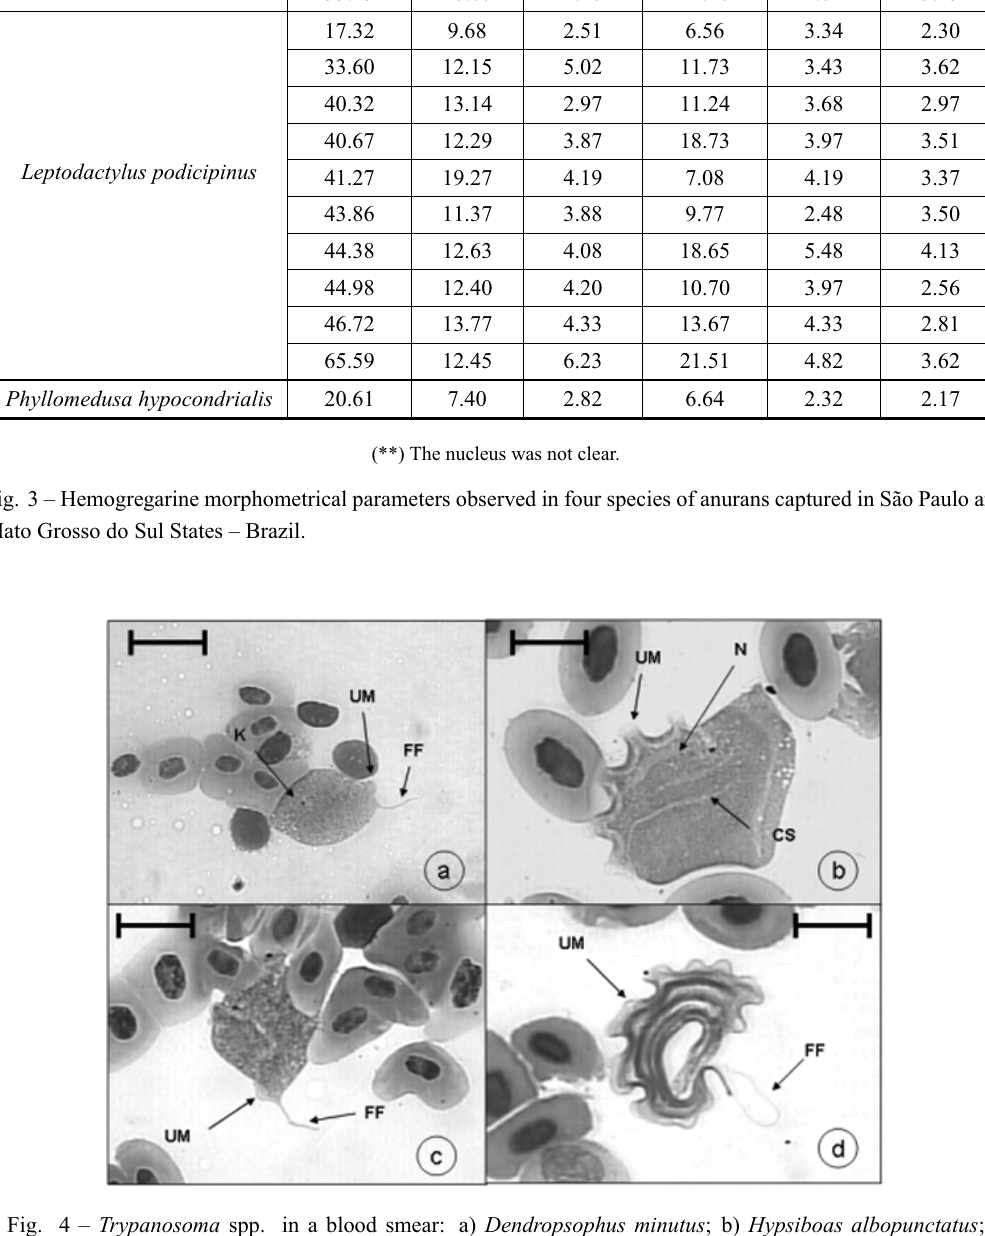
Fig. 4 – Trypanosoma spp. in a blood smear: a) Dendropsophus minutus ; b) Hypsiboas albopunctatus ; c) Dendropsophus minutus ; d) Leptodactylus labyrinthicus . Kinetoplast (K), Undulating Membrane (UM), Nucleus (N), Costate Surface (CS), Free Flagellum (FF). Scale bar = 10 μ m. Giemsa stained thin blood